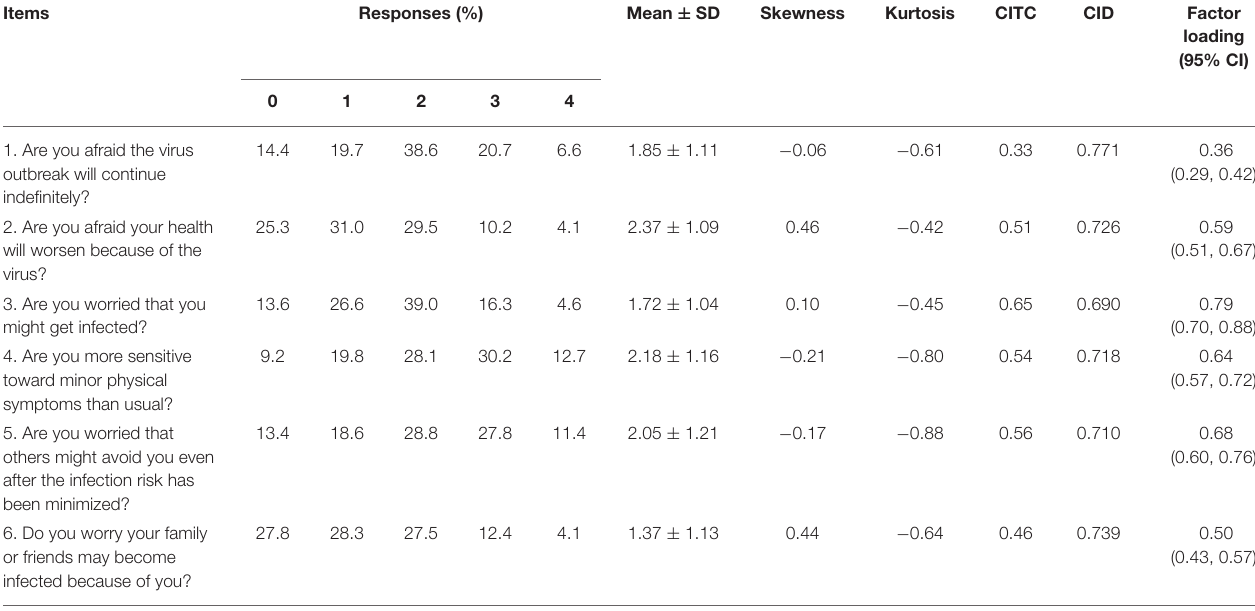
TABLE 2 | Factor structure of the SAVE-6 scale and factor loadings.